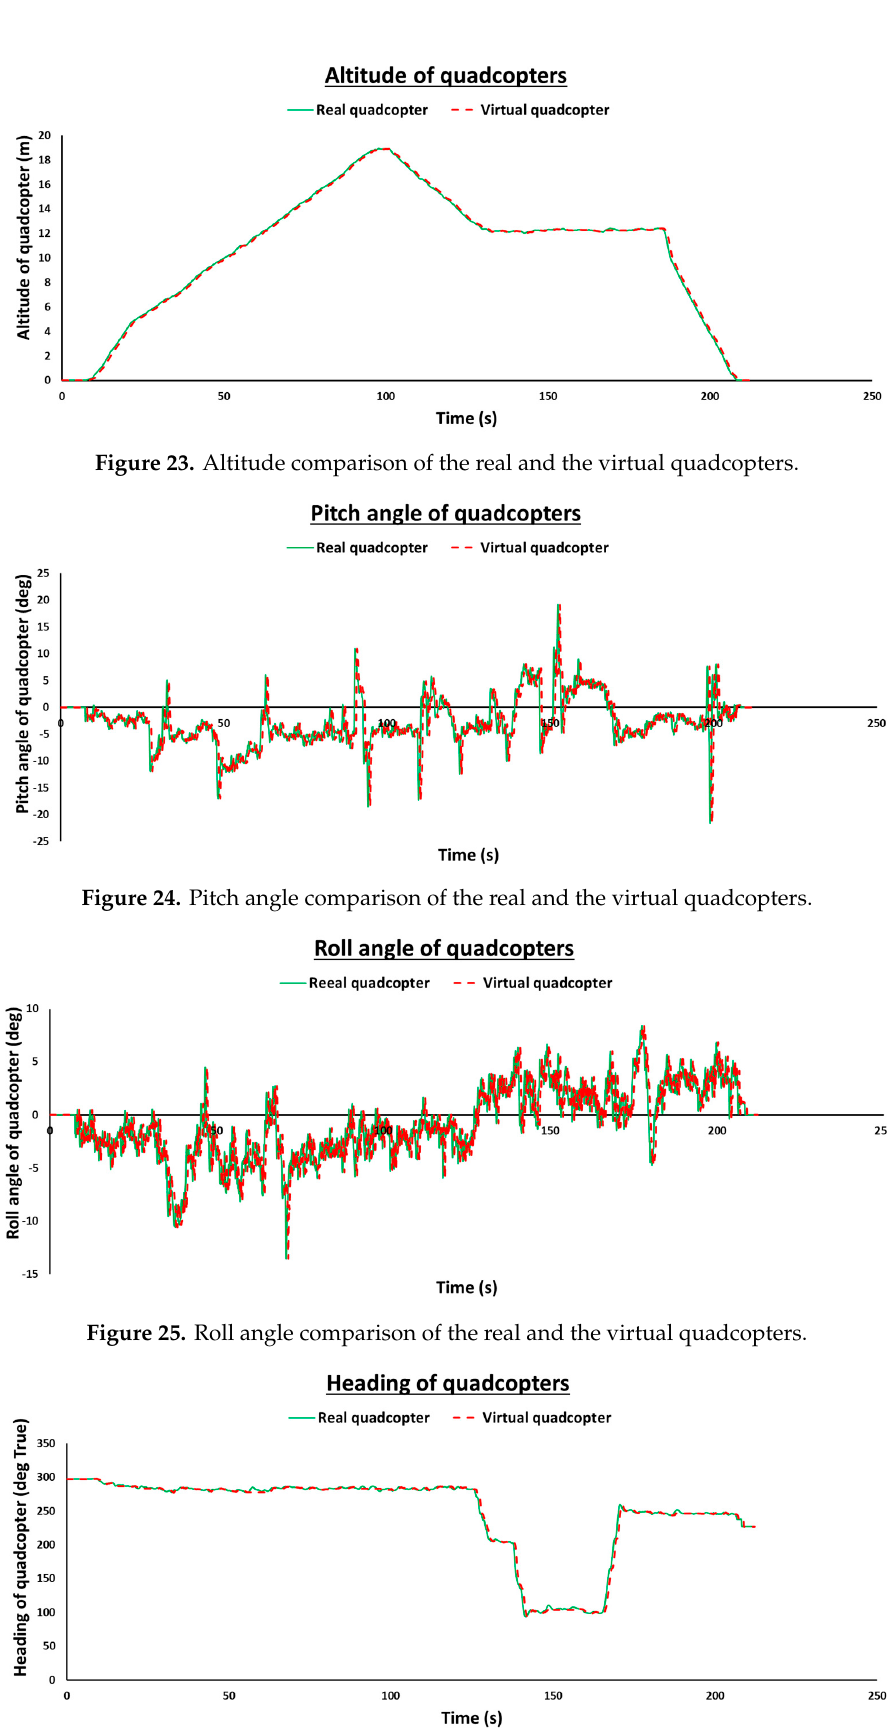
16 of 24 Figure 20. Data comparison procedure. Figures 21–26 illustrate the flight data comparison of the real quadcopter and the virtual quadcopter. Here, we compared the flight data from Flight Task 1. The latitude, longitude, altitude, pitch angle, roll angle, and the heading comparison of the real and virtual quadcopters from Flight Task 1 are shown in Figures 21–26, respectively. In Figures 21 ‐ 26, the continuous line indicates the real quadcopter’s data, and the broken line represents the virtual quadcopter’s data. Figure 21. Latitude comparison of the real and the virtual quadcopters.